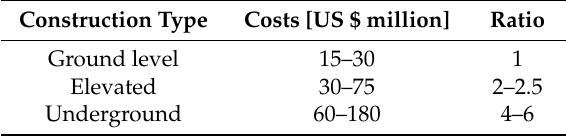
Figure 7. Progress of the process of the station layout optimization. Table 5. Indicative costs of a metro line per one kilometer [38].